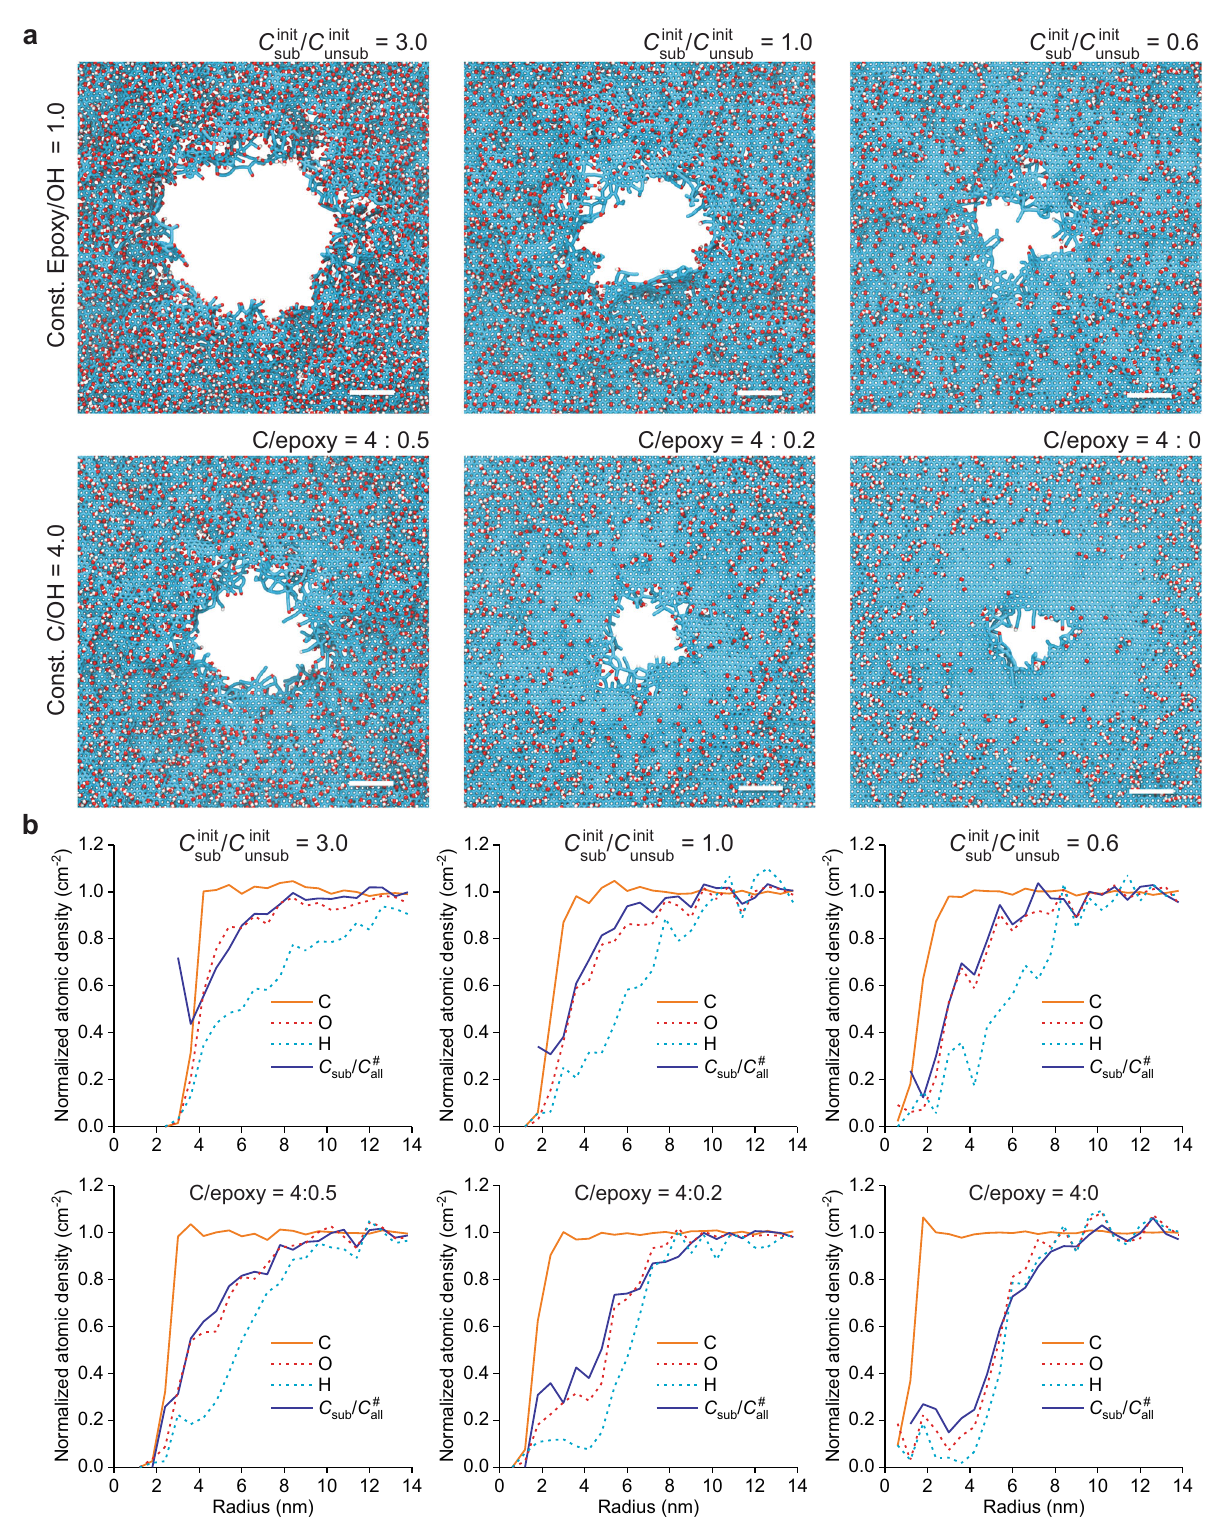
Fig. 5 | MC-RxMDmodeling of167MeV Xeion passage through single-layer GO ofdifferent compositions.a Finalstructures 0.1ns afterprojectile passage; the scale bar is 2nm. b Respective radial distributions of normalized atomic densities and normalized local substitution degrees ( C sub = C # all